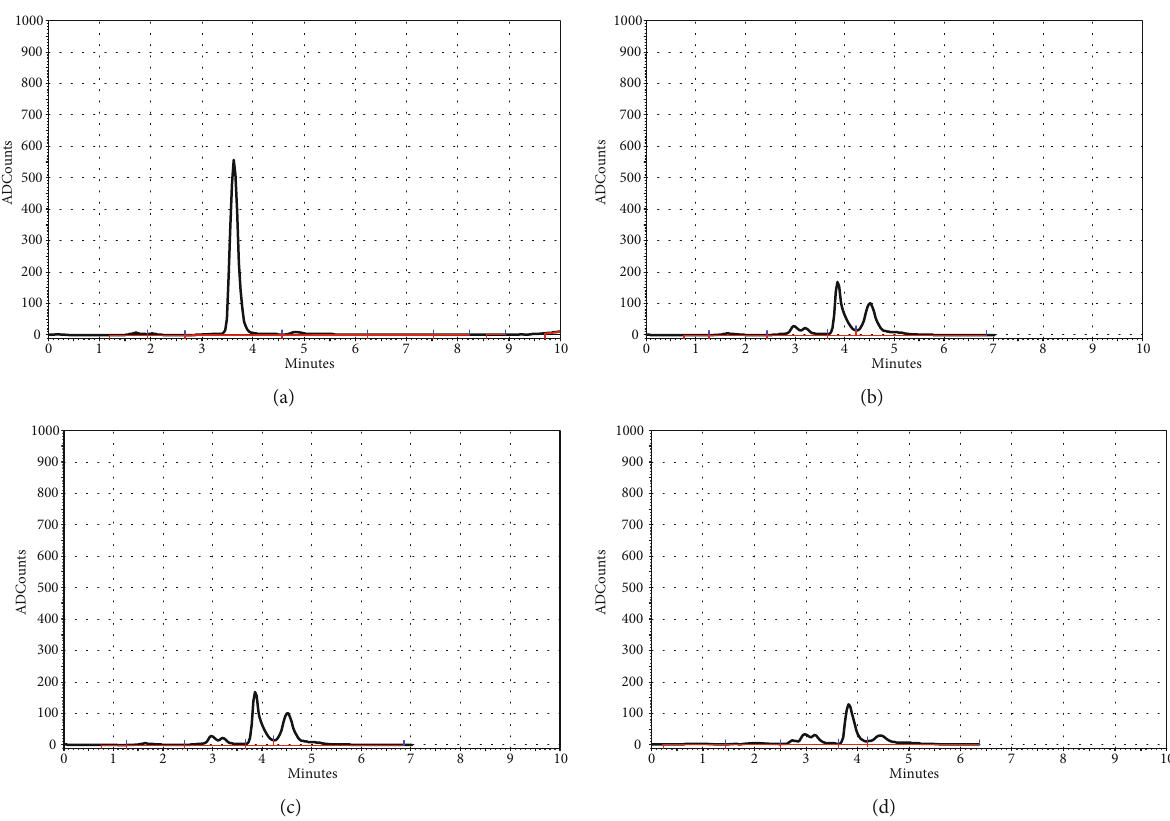
Figure 5: Nonylphenol HPLC spectrum. (a) Standard sample of NP (20 μ g/ml) and a sample of NP in the testicular tissue (200mg) of the NP25 group. (b) The sample of NP in the testicular tissue (200mg) of the NP25 group. (c) The sample of NP in serum of the NP+MLT20 group. (d) The sample of NP in serum of the NP+MLT10 group ( n = 4 ). NP: nonylphenol; MLT: melatonin.